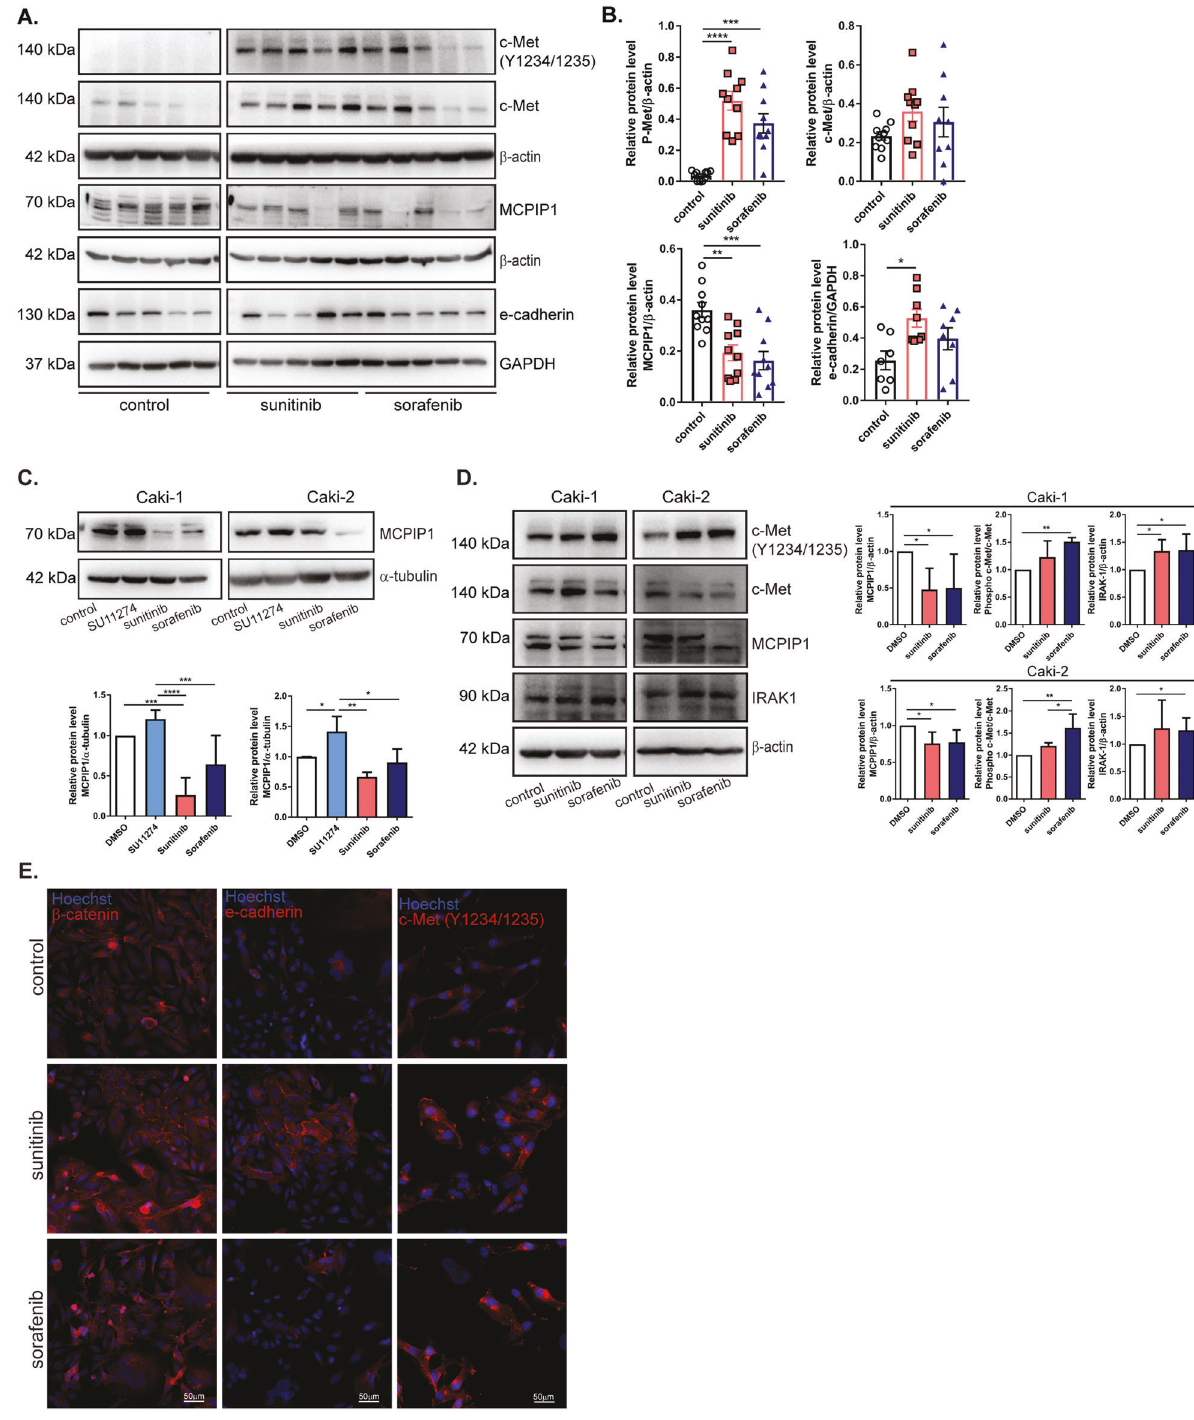
Fig. 6 Effect of drugs treatment on MCPIP1, IRAK1, and c-Met receptor. A Western blot from resistant tumor specimens, collected 6 weeks after resistant RCC cell injections, with GAPDH as the loading control. N = 5 per group. B Densitometric quanti fi cation of resistant tumor samples. The results are presented as the mean ± SEM. P-Met, c-Met, MCPIP1 graphs: N = 10 per group; E-cadherin graph: N = 8 per group. C Representative western blot of Caki cells after 3 weeks of treatment with SU11274, sunitinib or sorafenib, with α -tubulin as a loading control. Densitometric analysis of MCPIP1 protein level. D Western blot of Caki cells after 24 h treatment with sunitinib or sorafenib with β -actin as a loading control. Densitometric quanti fi cation of western blot results. The results are presented as the mean ± SEM. P values were estimated using one-way ANOVA with post hoc Tukey ’ s multiple comparison test. * P < 0.05; ** P < 0.01; *** P < 0.001; **** P < 0.0001. E Images of immuno fl uorescence staining of Caki-1 cells after one week of treatment with sunitinib or sorafenib. Nuclei visualized with Hoechst.